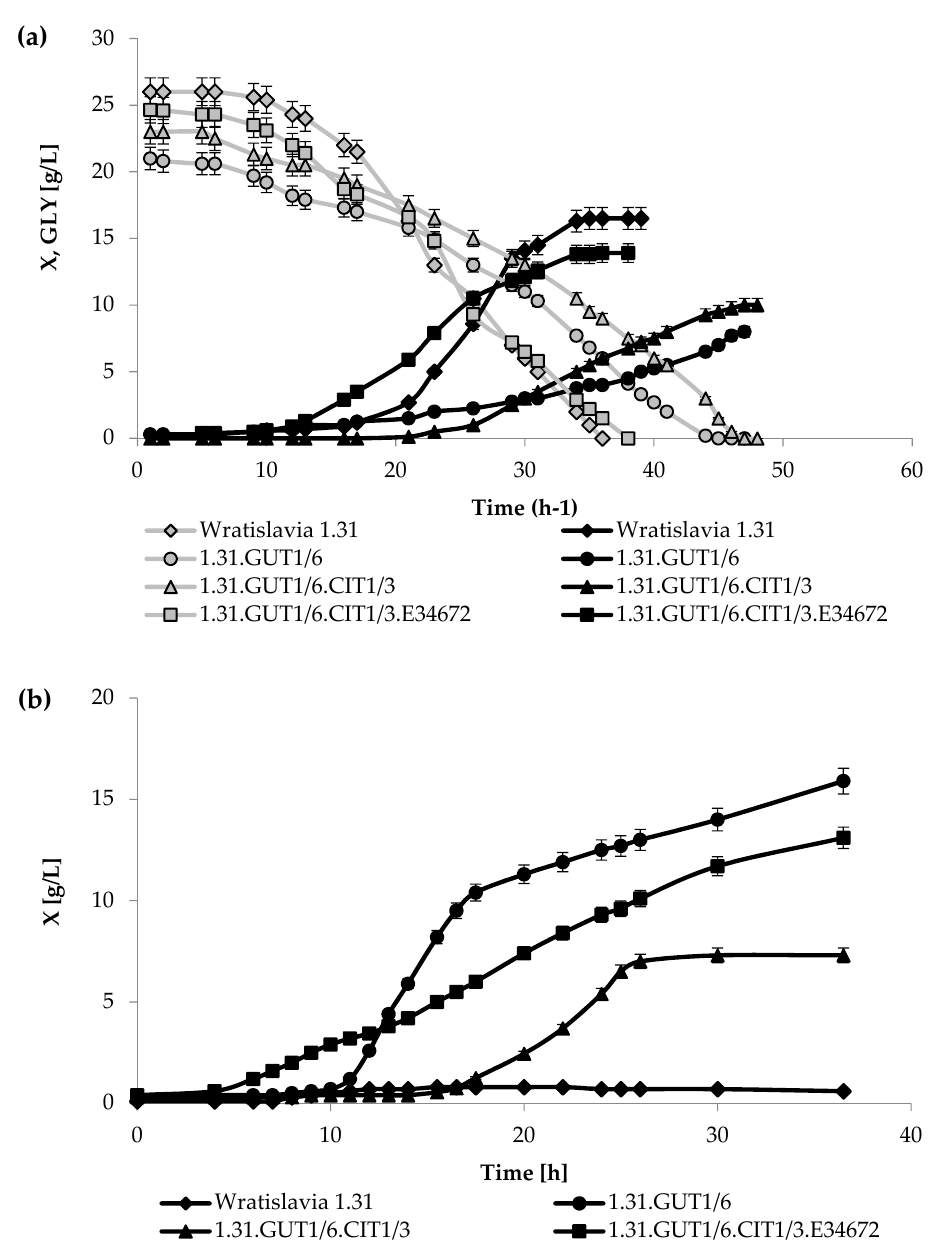
Figure 1. Kinetics of yeast growth (X; black lines) and glycerol (GLY; gray lines) consumption of Wratislavia 1.31 and transformant strains of Y. lipolytica growing on glycerol ( a ) and rapeseed oil ( b ). Error bars represent the standard deviations of duplicates.